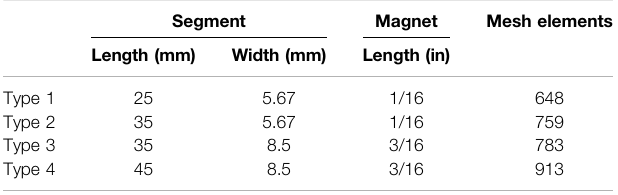
TABLE 2 | MASR geometry and number of quad mesh elements used for each type of sample. Segment Magnet Mesh